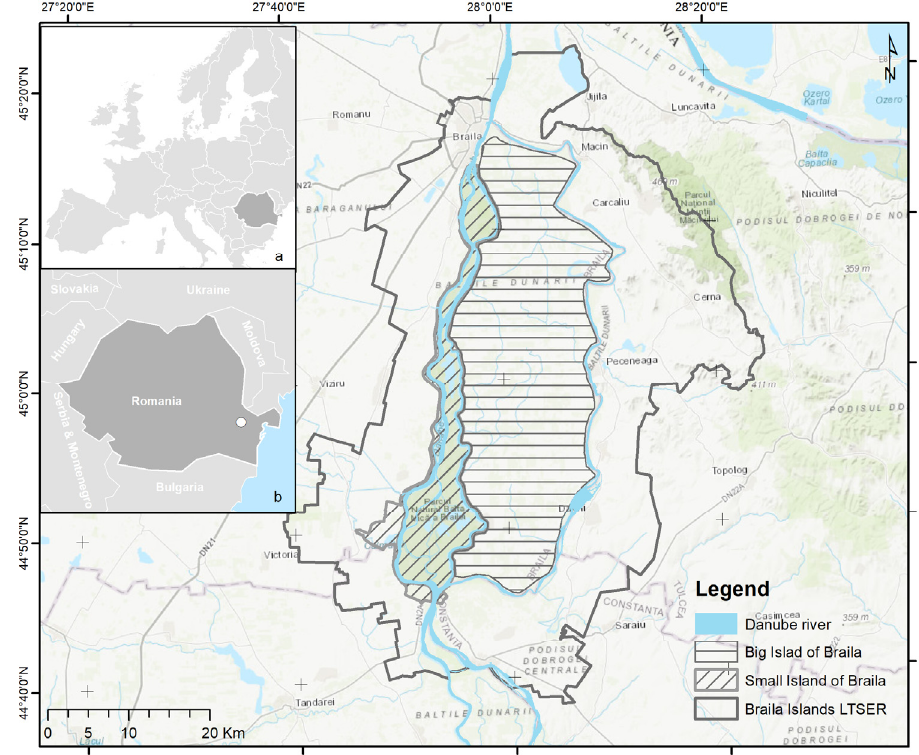
Figure 2. Map of the Br ă ila Islands LTSER platform. ( a ) European location of the case study area; ( b ) location in the country.